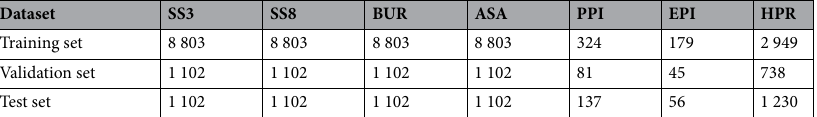
Training and evaluation During training, the loss was determined by categorical cross entropy for classification tasks, and mean absolute error for regression tasks. Model performance was assessed by the Pearson correlation coefficient (PCC) for the regression tasks (ASA and HPR), accuracy (ACC) for the classification of the structural components (SS3 and SS8) and the identification of the buried residues, and the area under the receiver operating characteristic curve (AUC ROC) for the interface predictions (PPI and EPI). Note that the range of the PCC is between −1 and 1, whereas the range of the ACC and AUC is between 0 and 1. We determined random prediction performances for all downstream prediction tasks in the benchmark set. For the SS3, SS8, and BUR prediction task this random performance is set to the fraction of the number of majority-class residues over all residues. For the ASA and HPR we compare the labels with a sequence of the same size sampled from a standard normal distribution. The expected random expected performance, in this way, is close to zero. For the two interface prediction tasks we set the baseline to the random performance of a ROC curve, which is 0.5. The previously described pre-trained medium and base models were used for the hyperparameter tuning. The performance, per downstream task, between the medium and base model were compared. For comparison, we also trained the downstream tasks on both models excluding the pre-training step. During training of the pre-training models two checkpoints were stored manually. This includes the checkpoints of the medium model at step 500 000 and 1 600 000, and of the base model at step 350 00 and 700 000. The predictive performance of the different downstream tasks was evaluated over these checkpoints to check for overfitting. All fine-tuning models were trained ten times, after which the mean performance and standard error on the validation set was determined.